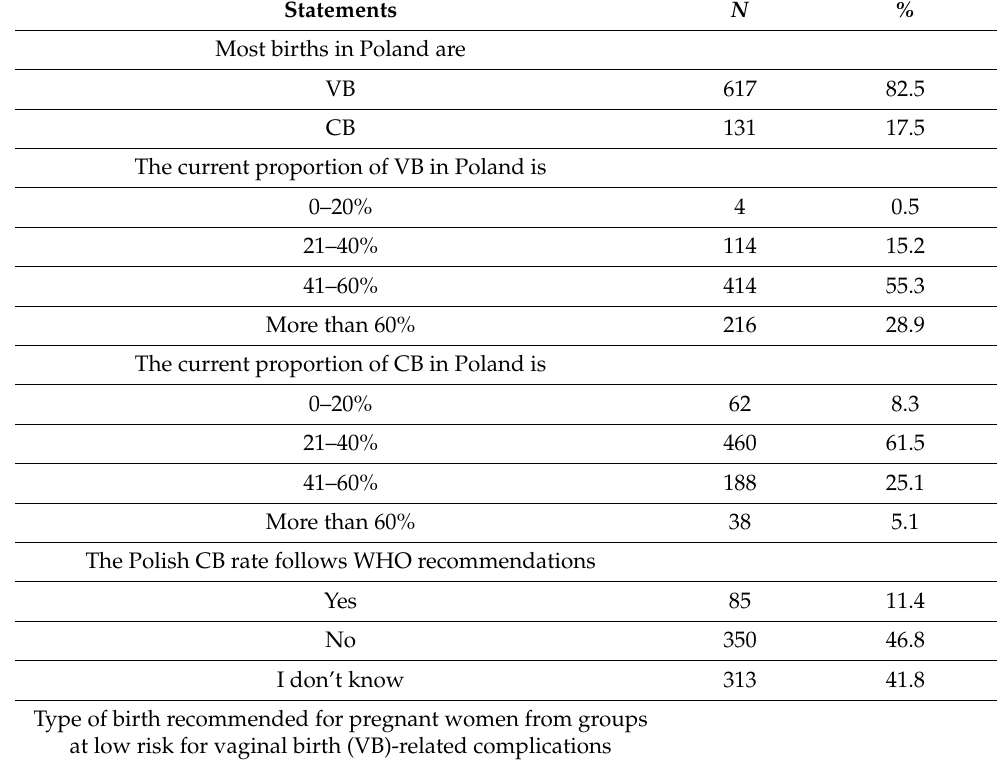
Table 2. Overall opinions and knowledge concerning vaginal/cesarean